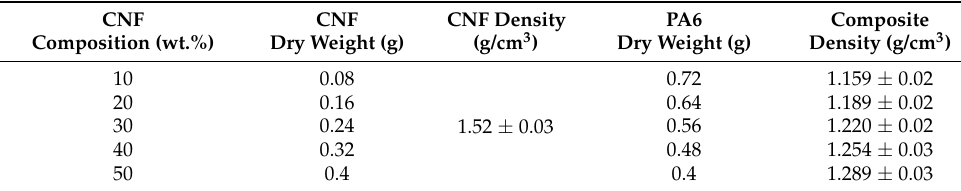
Table 2. Weight specifications for casting PA6-CNF